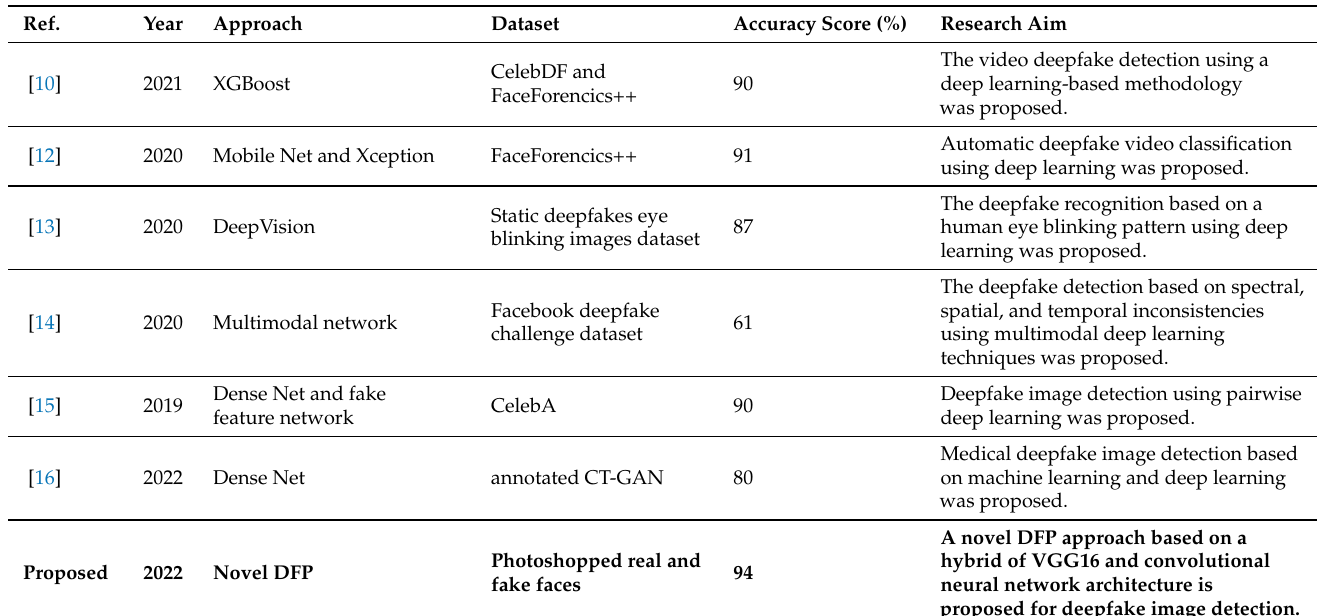
Table 1. The deepfake detection-related literature summary and comparative analysis.